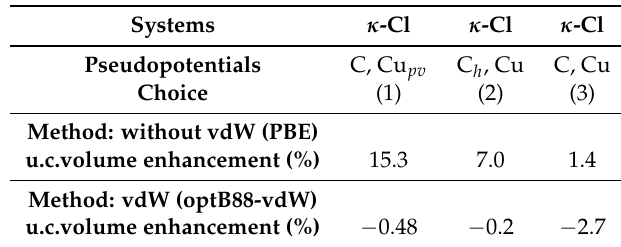
Table 2. Unit cell volume enhancement (in %), defined as relative deviation from the experimental value, of κ -Cl obtained from ab initio calculations without vdW (based on the PBE functional) and with vdW (based on the optB88-vdW functional), using a different set of pseudopotentials denoted as choices (1), (2), and (3).